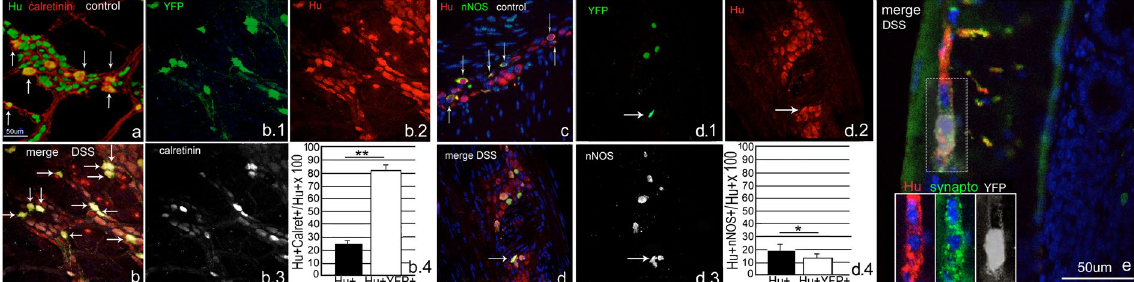
Figure 10. Newly formed neurons following colitis are predominantly calretinin excitatory motor neurons, which form synapses. In the myenteric ganglia of control mice, approximately 25% of Hu + neurons express calretinin (( a ) Hu green, calretinin red, arrows point to double-expressing cells). In our model, however 82% of YFP + neurons (thus the newly formed neurons) express calretinin ( b – b.4 YFP green, calretinin white, Hu red. Arrows in b point to triple-expressing cells). nNOS is normally expressed by 19% of Hu + neurons in control (( c ) nNOS green, Hu red. Arrows point to double-expressing cells), but was only found to be expressed by 13% of YFP + neurons post-colitis ( d.1 – d.4 YFP green, Hu red and nNOS white. Arrows point to triple-expressing cells). The newly formed neurons synthesize synapses as manifested by synaptophysin expression ( e ). * p < 0.05, ** p < 0.01. (All Images were taken at